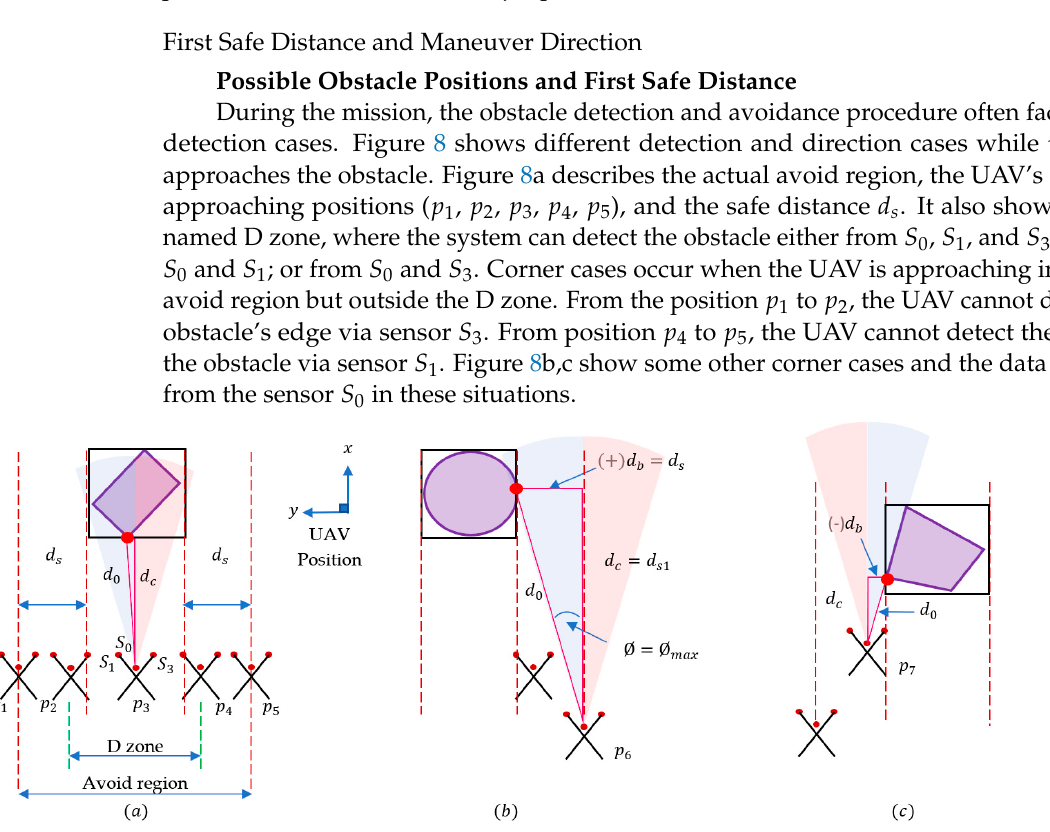
Figure 8. UAV’s possible predicted positions and detection calculation. ( a ) possible UAV placements, ( b ) Left side position, ( c ) Right side critical position.